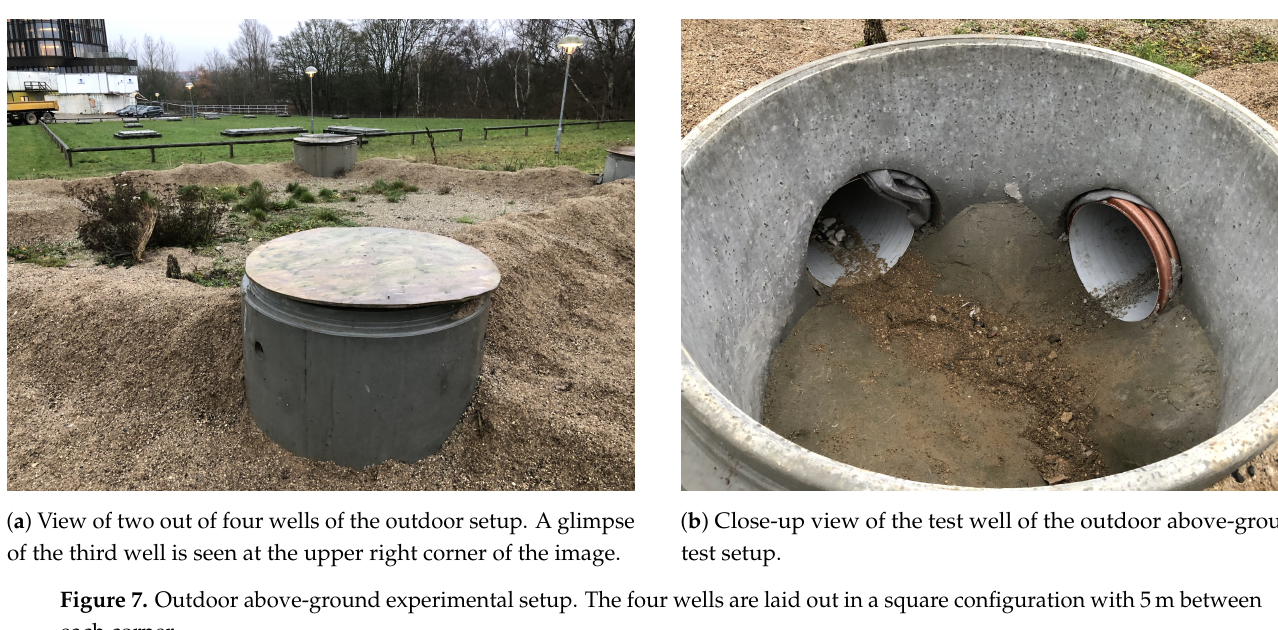
Figure 6. Laboratory experimental setup.